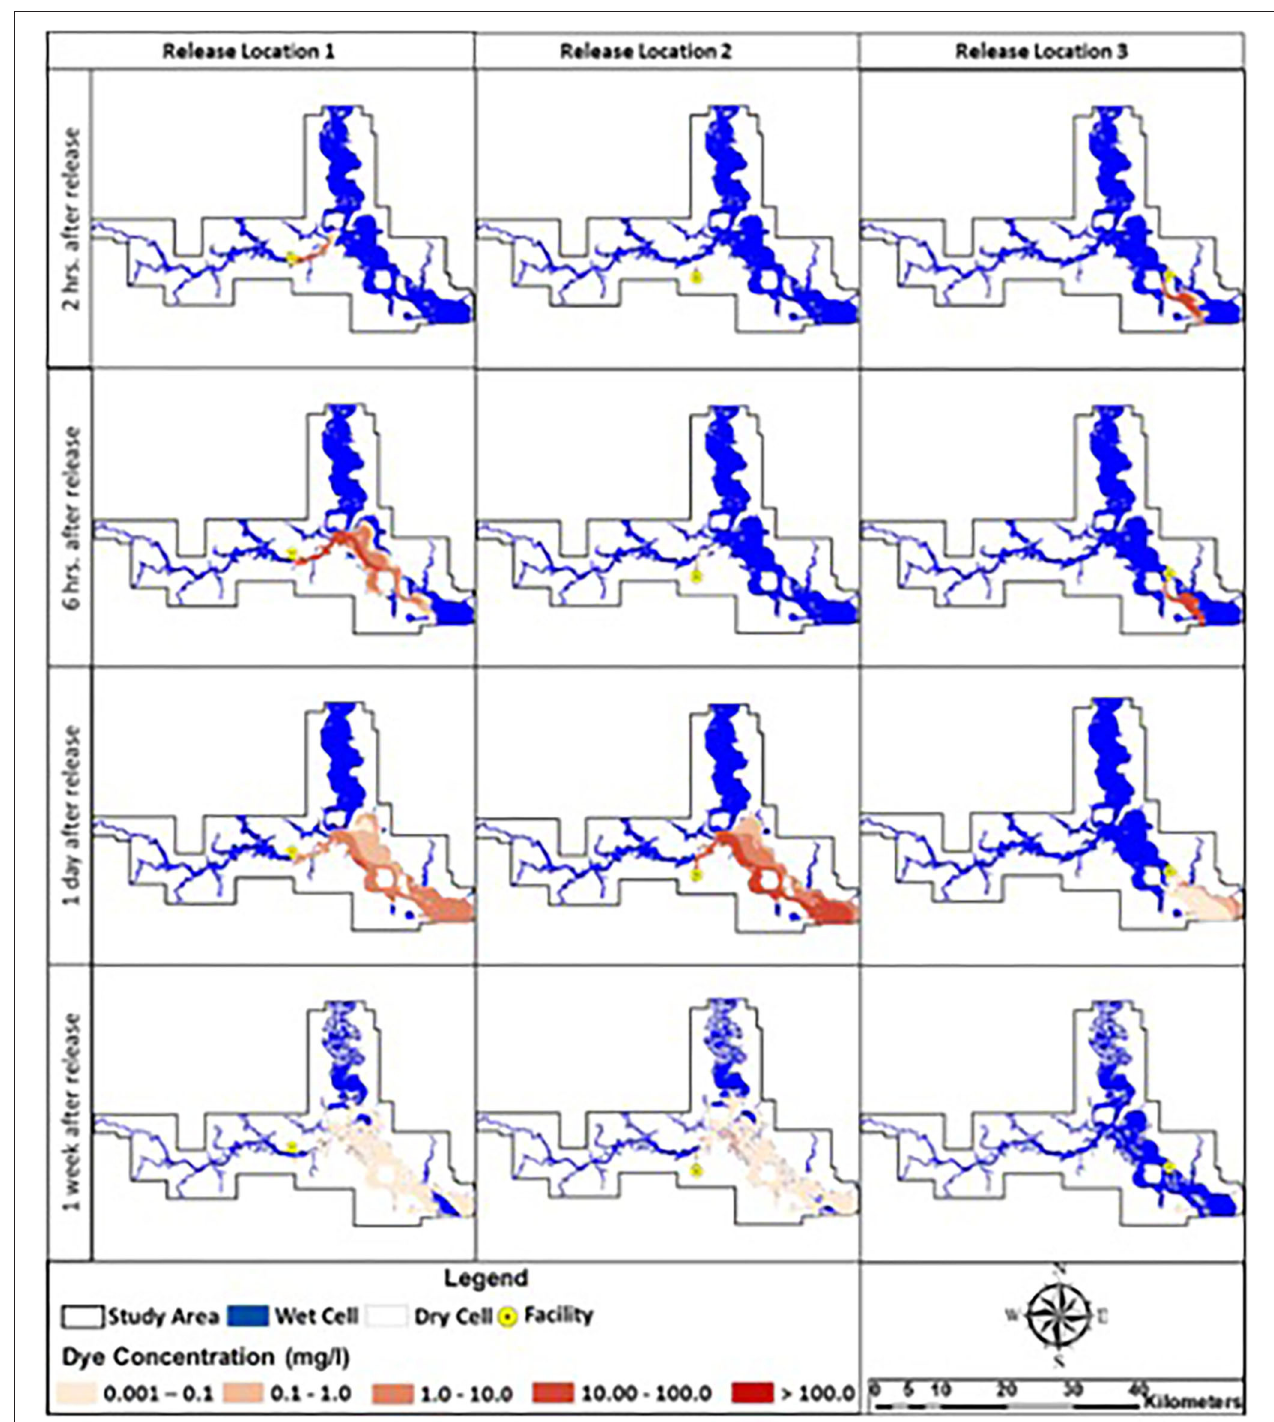
FIGURE 8 | Dye concentration for Hurricane Harvey at various times during and following the event for different release locations. Blue cells represent concentrations below 0.001 mg/l.